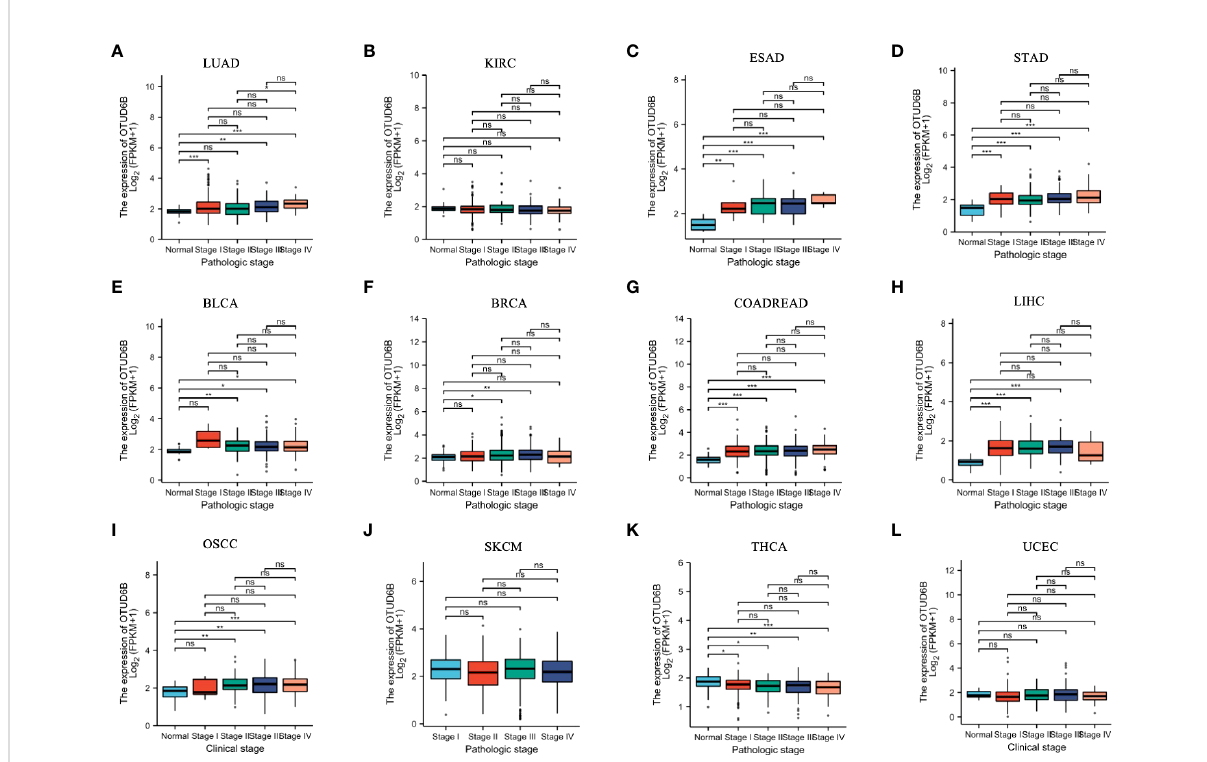
FIGURE 3 OTUD6B expression in different tumor stages. (A-L) Differential expression of OTUD6B in WHO stages in various tumors from TCGA database. (Ns, non-signi fi cant, *p < 0.05; **p < 0.01, ***p <